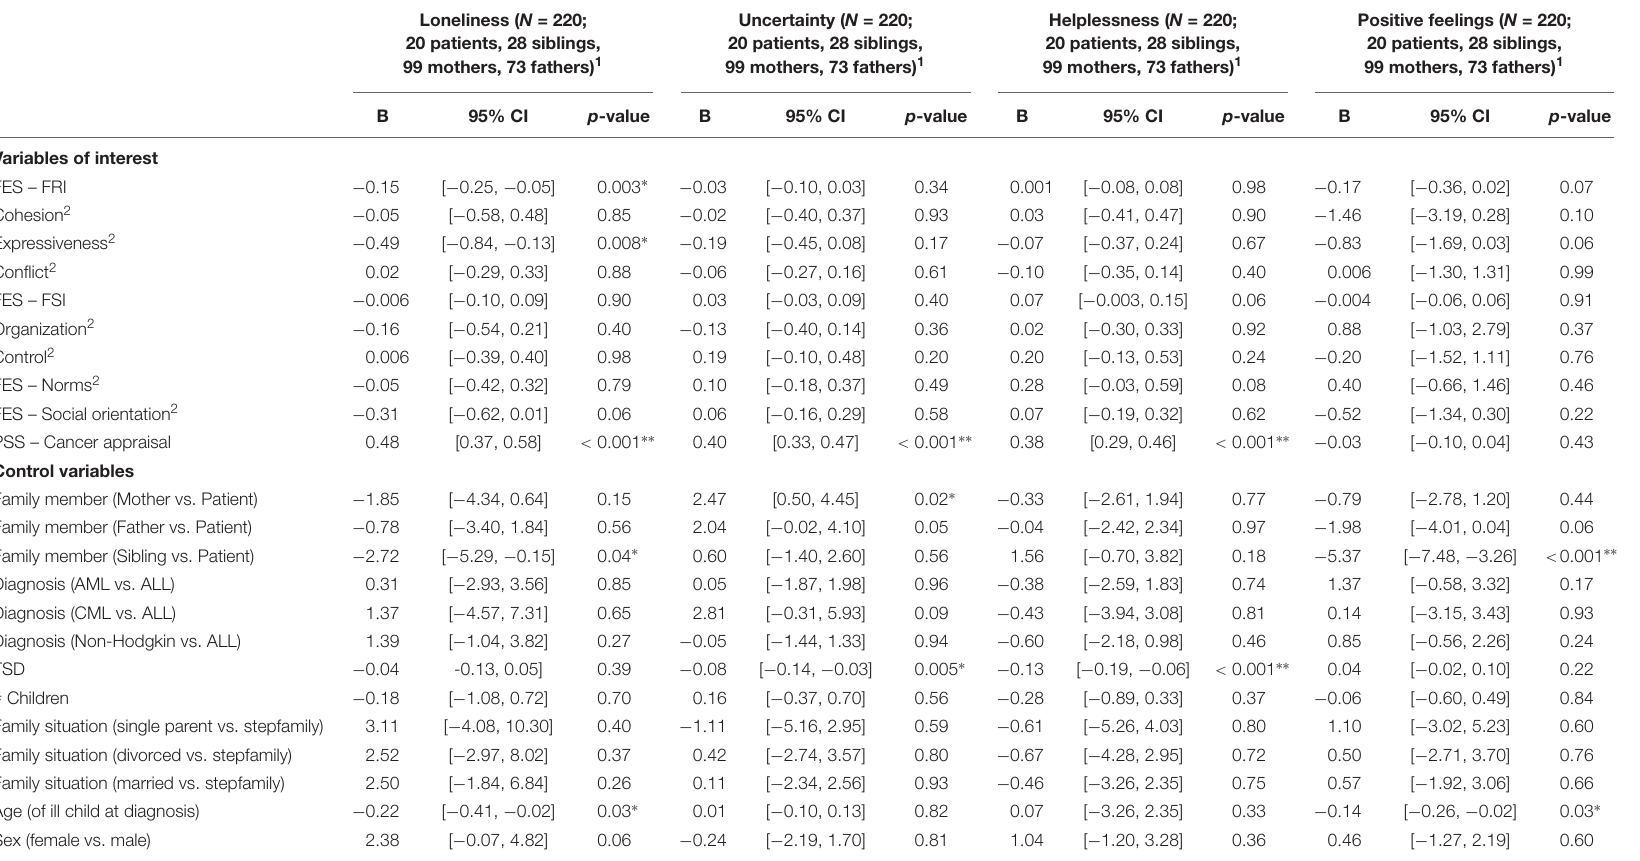
TABLE 3 | Final models for the associations between family functioning, cancer appraisal, and cancer-related emotions. Loneliness ( N =